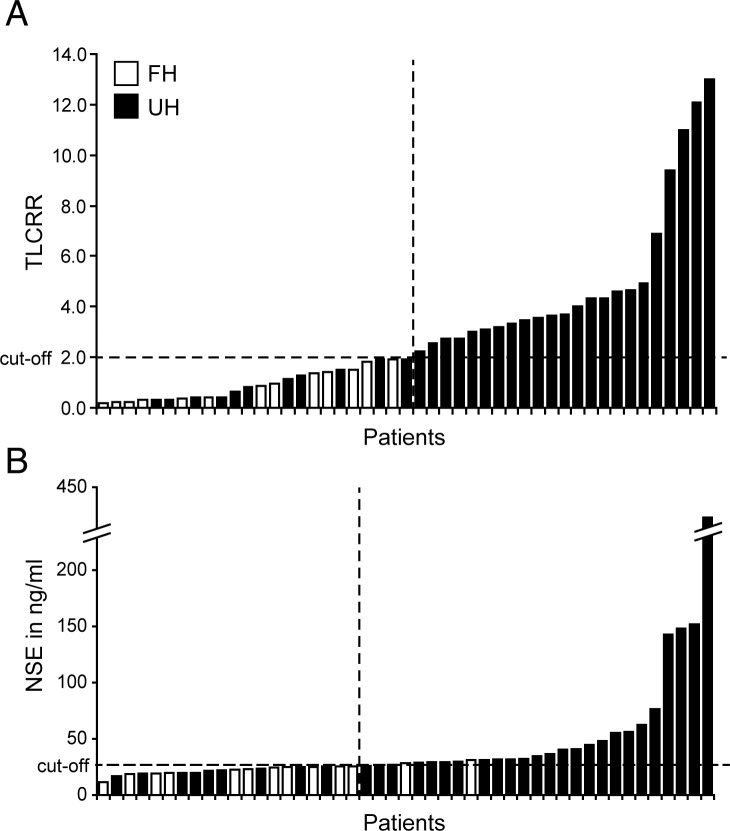
Results for (A) TLCRR and (B) serum NSE with corresponding histopathology for each patient (n = 47).Patients with unfavorable histopathology (UH) are shown with black bars, and patients with favorable histopathology (FH) are shown with white bars, all of which are ordered in ascending magnitude. Cut-off values determined by ROC analysis are indicated by horizontal lines. ROC = receiver-operating-characteristic, TLCRR = tumor-to-liver count-rate ratio, NSE = neuron-specific enolase.